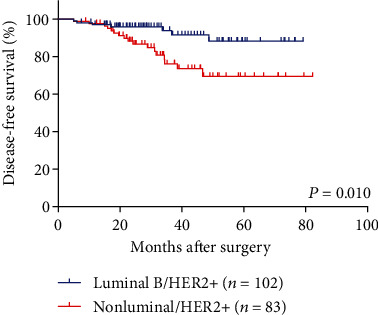
DFS curves of luminal B/HER2+ and nonluminal B/HER2+ patients in non-pCR patients.